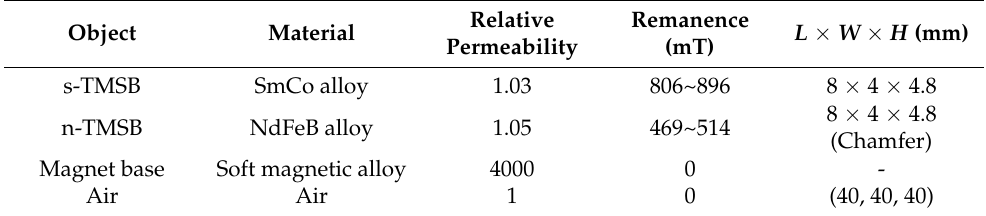
The magnetic flux density distribution is shown in Figure 3a. The influence of B r-S and B r-N on B a (point in the middle) is shown in Figure 3b. B a is basically increased with the increase of the remanence of the two TMSBs ( B r-S and B r-N ) that can be described by Equation (1). For this TMSP of accelerometer, a is 0.502 and b is 0.192: